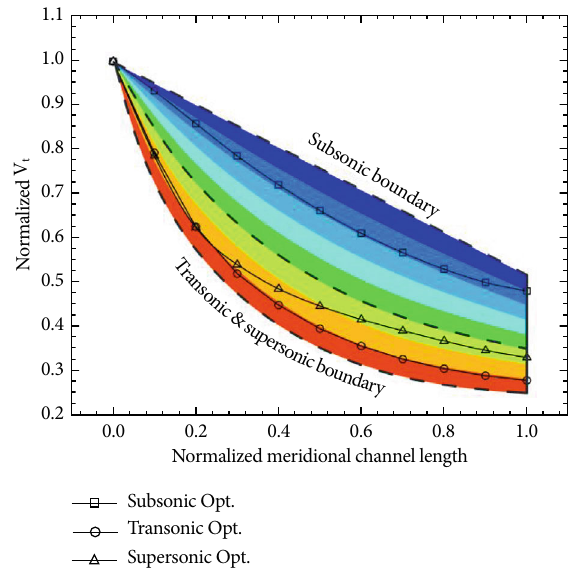
Figure 20: Optimal velocity distribution for di ff erent conditions.